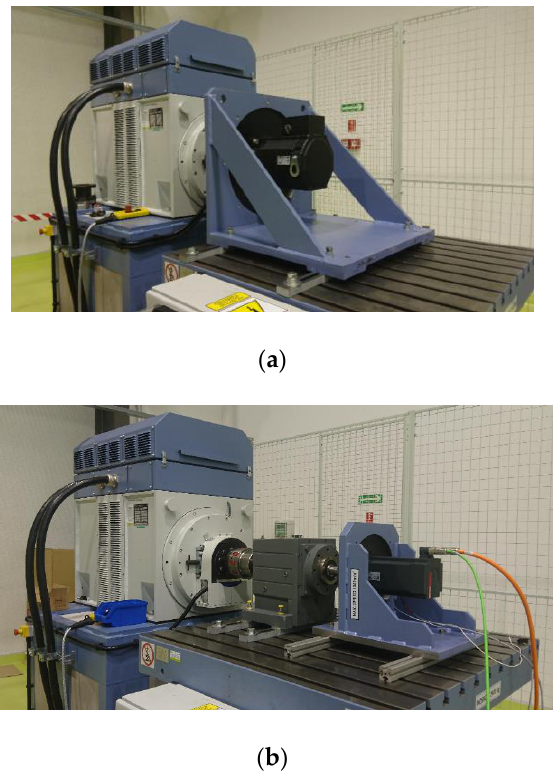
Figure 5. Permanent magnet motor mounted on the test bench of the dynamometer: ( a ) for hoist drive, ( b ) for the drive with the gear of jib rotation and trolley travel.